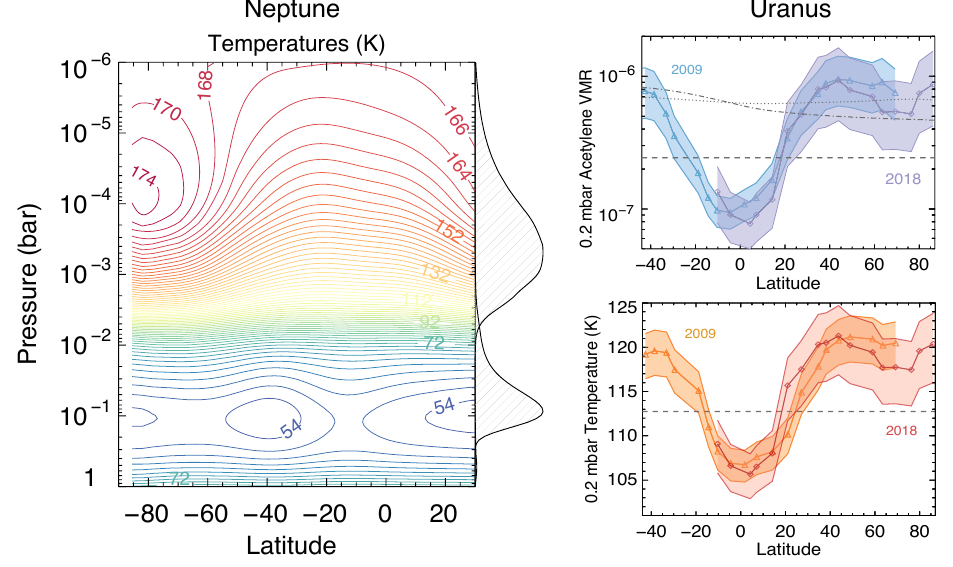
Figure 13. Retrieved stratospheric properties from ground-based images of the Ice Giants. Left: Neptune’s temperature structure, retrieved from 2020 VLT-VISIR imaging data [74]. Temperatures are indicated by the colored contours at 2 K intervals. The heights constrained by the data are suggested by the vertical curves on the right, with maxima contributions peaking near 100 and 0.5. A warm polar vortex is evident at south polar (planetocentric) latitudes. Right: Meridional gradients in C 2 H 2 (top) and temperature (bottom), consistent with Uranus’ observed stratospheric radiances (see Figure 14). Current data cannot differentiate between the two potential extreme solutions, given the ambiguous nature of the stratospheric emission